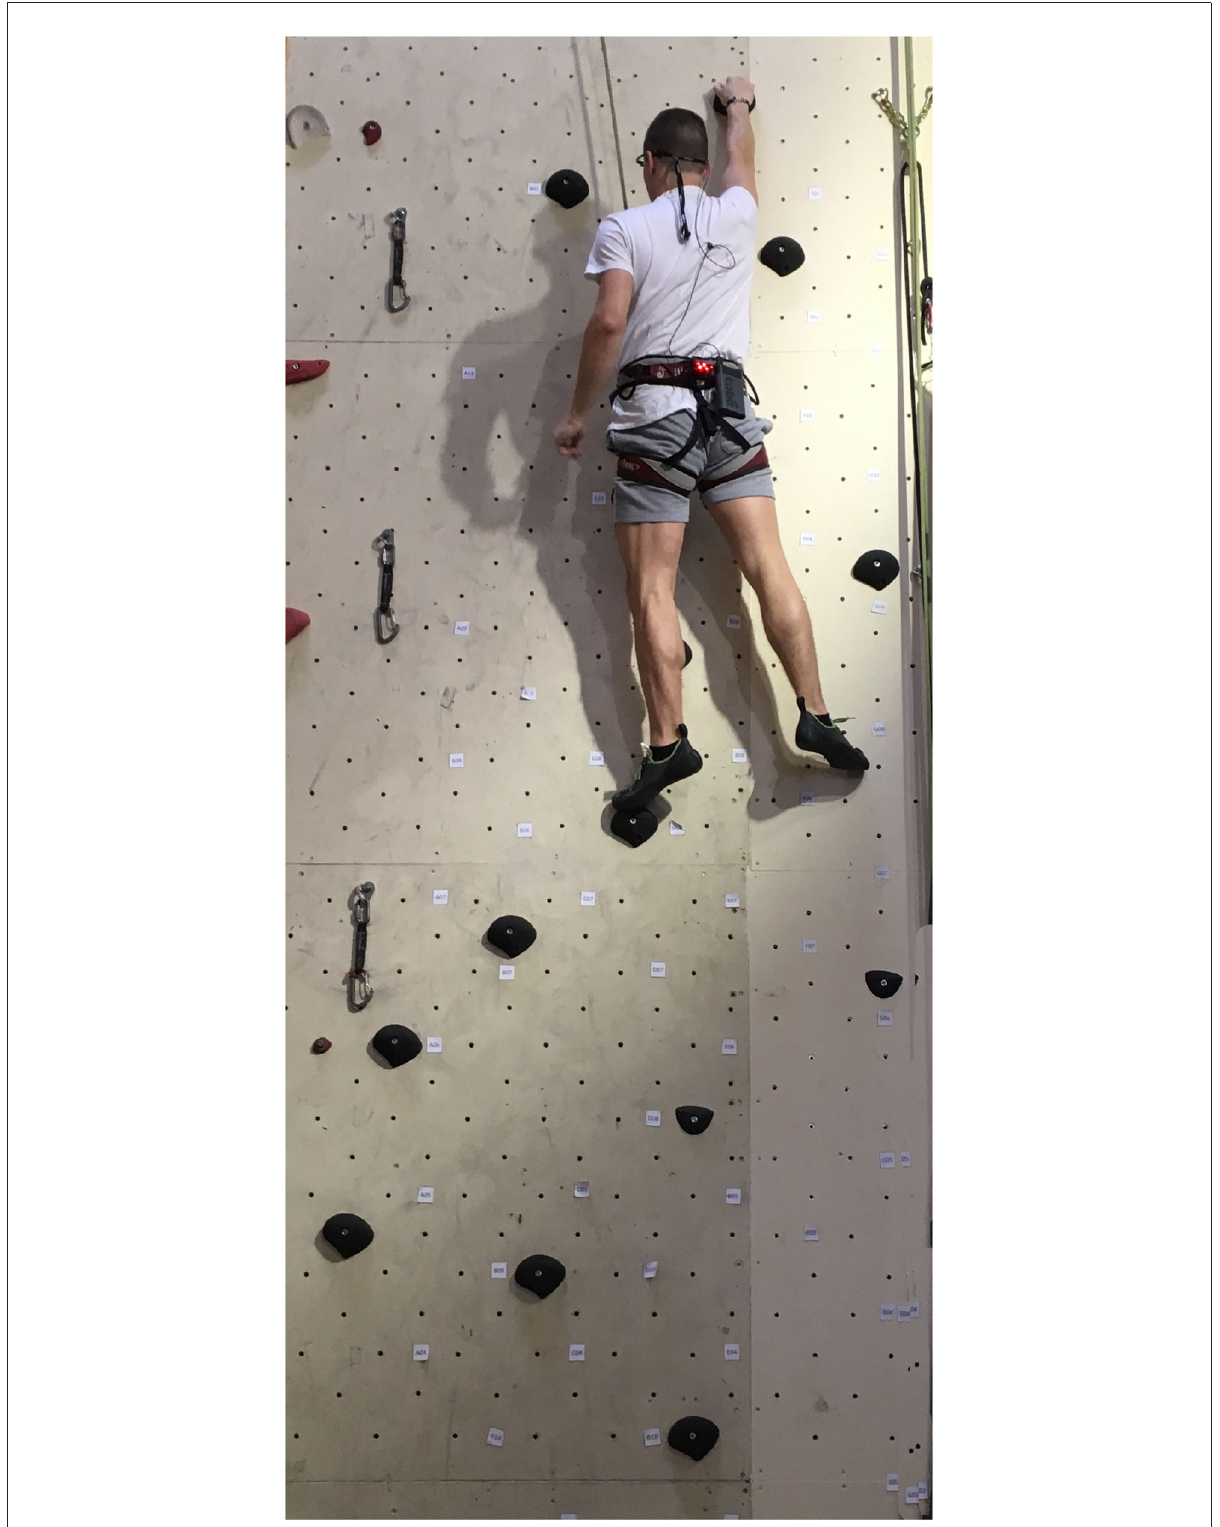
FIGURE2 Climbing route setup: the led lamp light to track the trajectory of the climber is attached to the harness along with the IMU. The handholds on the artificial wall are equipped with sensors.